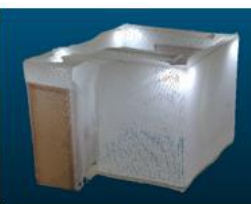
Figure 17. Subsampled and cleaned point cloud of the room scenes.